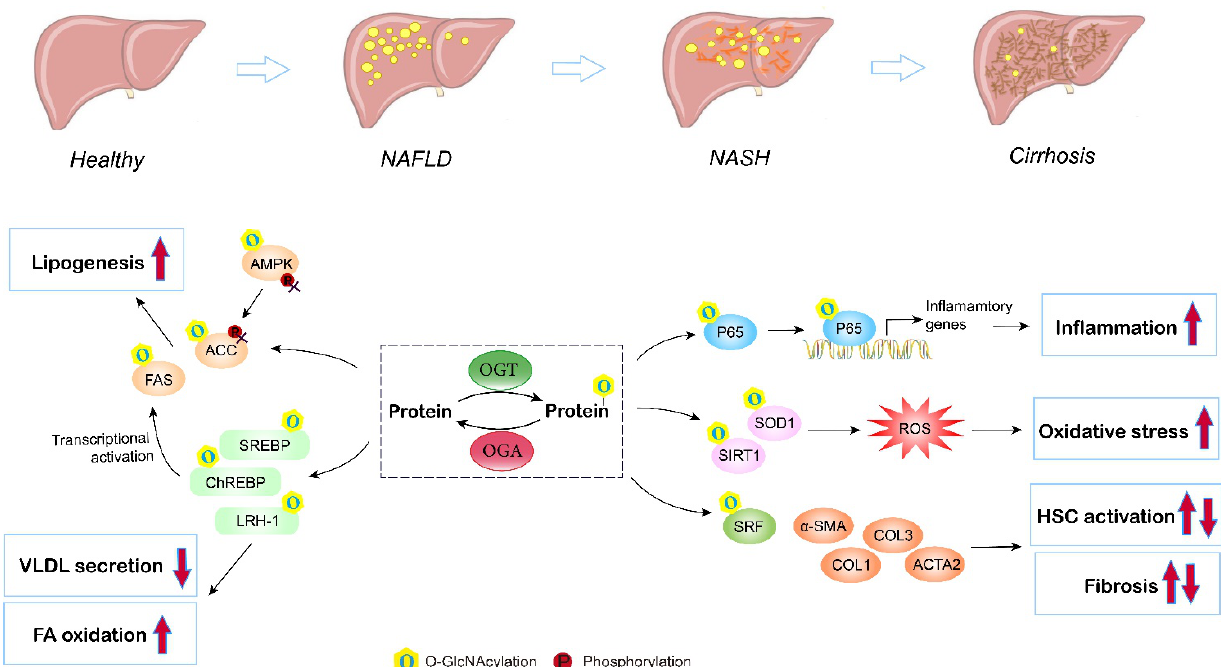
Figure 4. Role of O-GlcNAcylation in NAFLD/NASH development. Elevated O-GlcNAcylation induces de novo lipogenesis through direct regulation of the lipogenic target gene FAS and ACC, and by mediating the nuclear translocation of the master lipogenic transcription factors SREBP-1, ChREBP, and LXR. O-GlcNAcylation of LRH-1 promotes fatty acid oxidation and inhibits liver VLDL secretion. O-GlcNAc-modification of P65 induces translocation and activates NF-kB signaling, thus promoting liver inflammation and NASH. Additionally, O-GlcNAcylation enhances hepatic oxidative stress by triggering inhibiting activities of antioxidant enzymes (SIRT1 and SOD1). Moreover, studies have shown that O-GlcNAcylation influences hepatic stellate cell (HSC) activation, but the exact